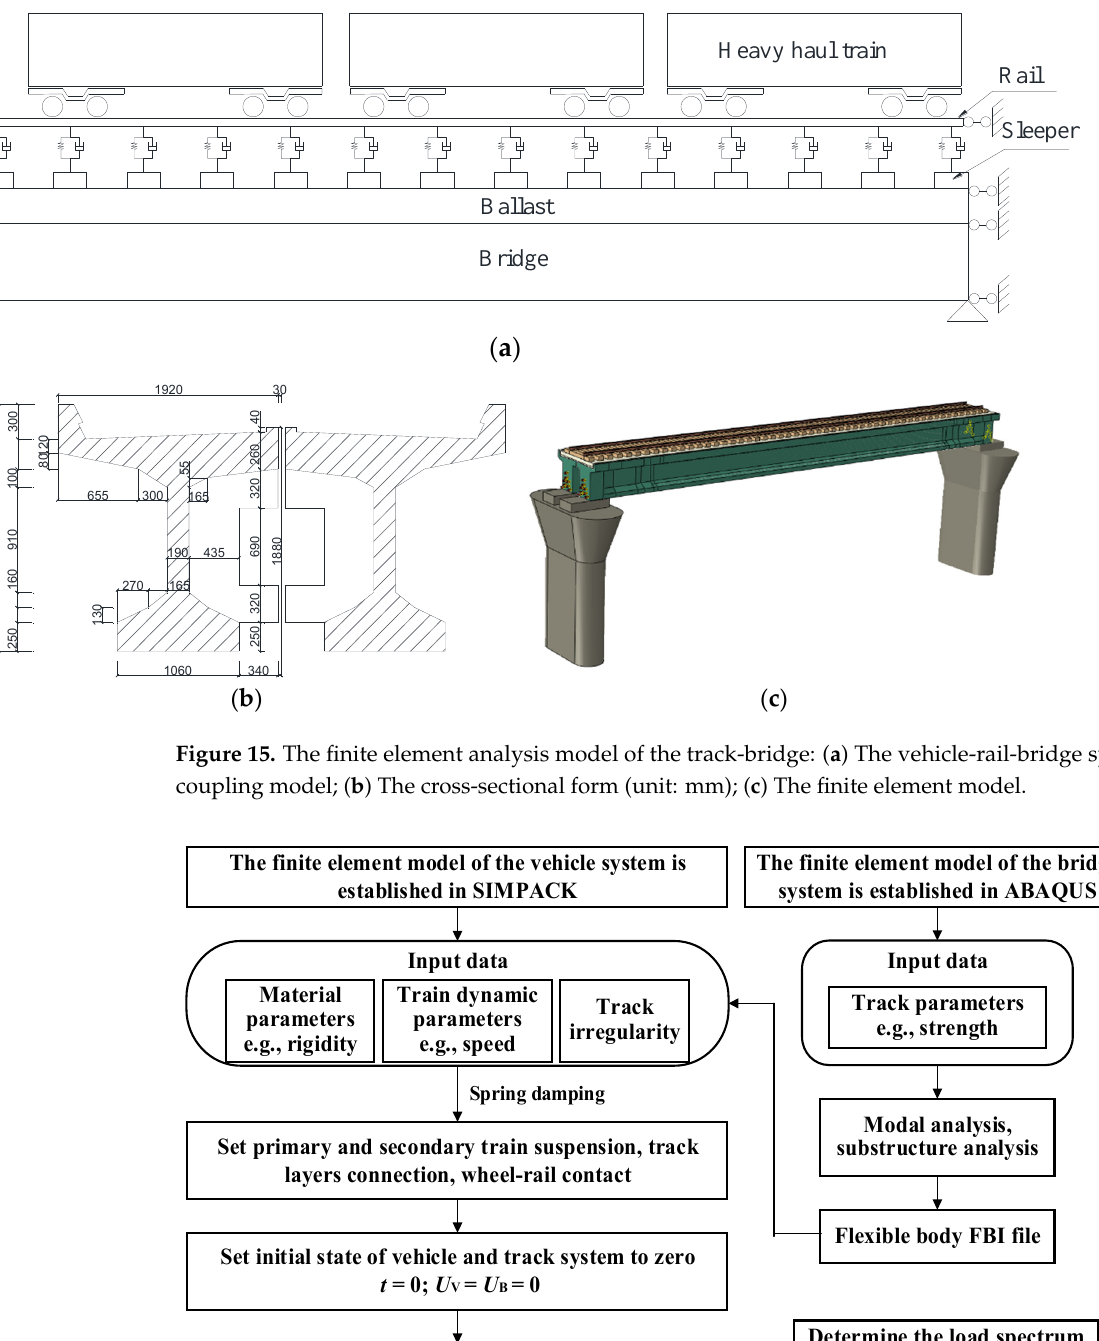
Figure 15. The finite element analysis model of the track-bridge: ( a ) The vehicle-rail-bridge system coupling model; ( b ) The cross-sectional form (unit: mm); ( c ) The finite element model.